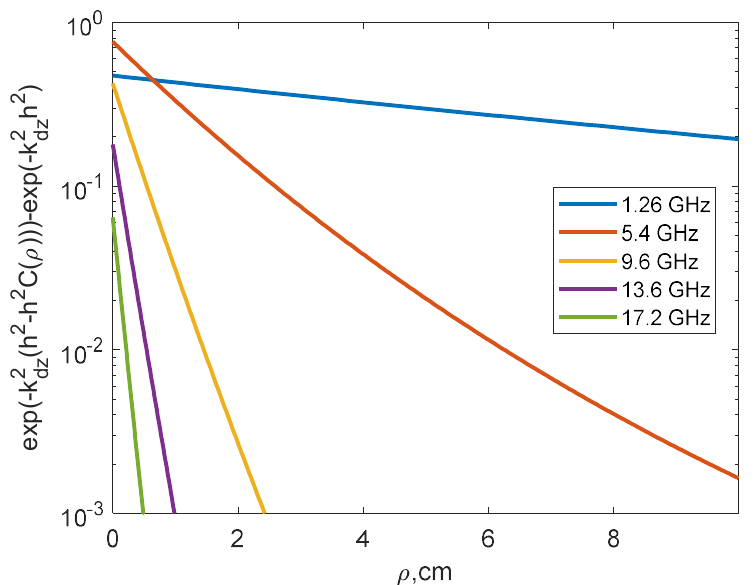
(cid:0) − (cid:1) − (cid:0) − (cid:1) k 2 h 2 ( 1 − C ( ρ )) exp k 2 h 2 dx dx